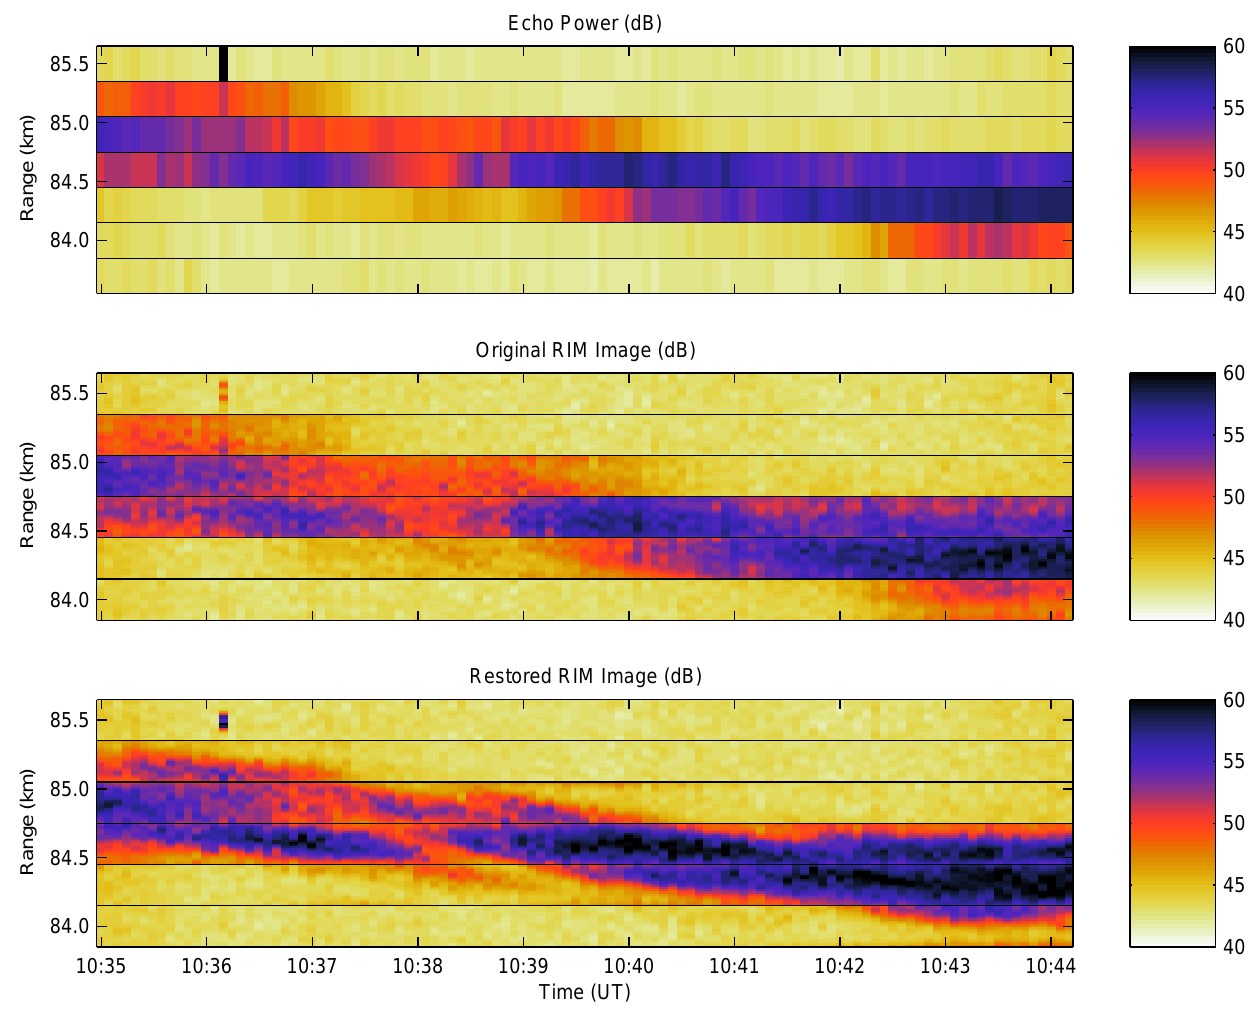
Fig. 10. Smaller region of the overall data set. Echo power, corrupted RIM image, and phase-calibrated RIM image are shown in the figure. 1993; Czechowsky and R¨uster, 1997; Chilson et al., 2001).